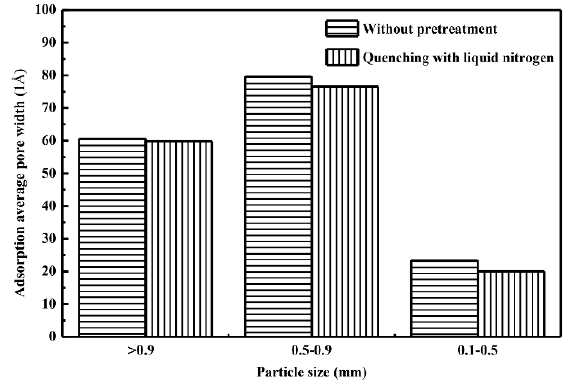
Figure 11. Average pore width of the samples.